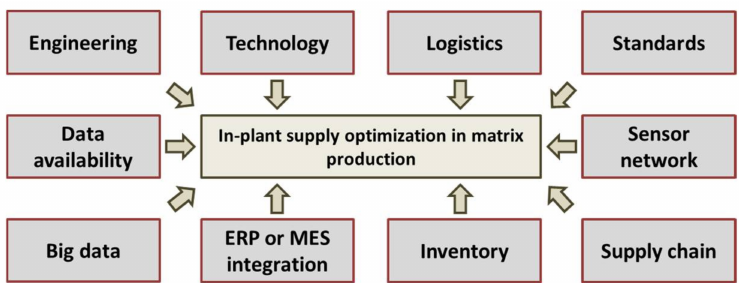
Figure 10. Challenges regarding the proposed model and